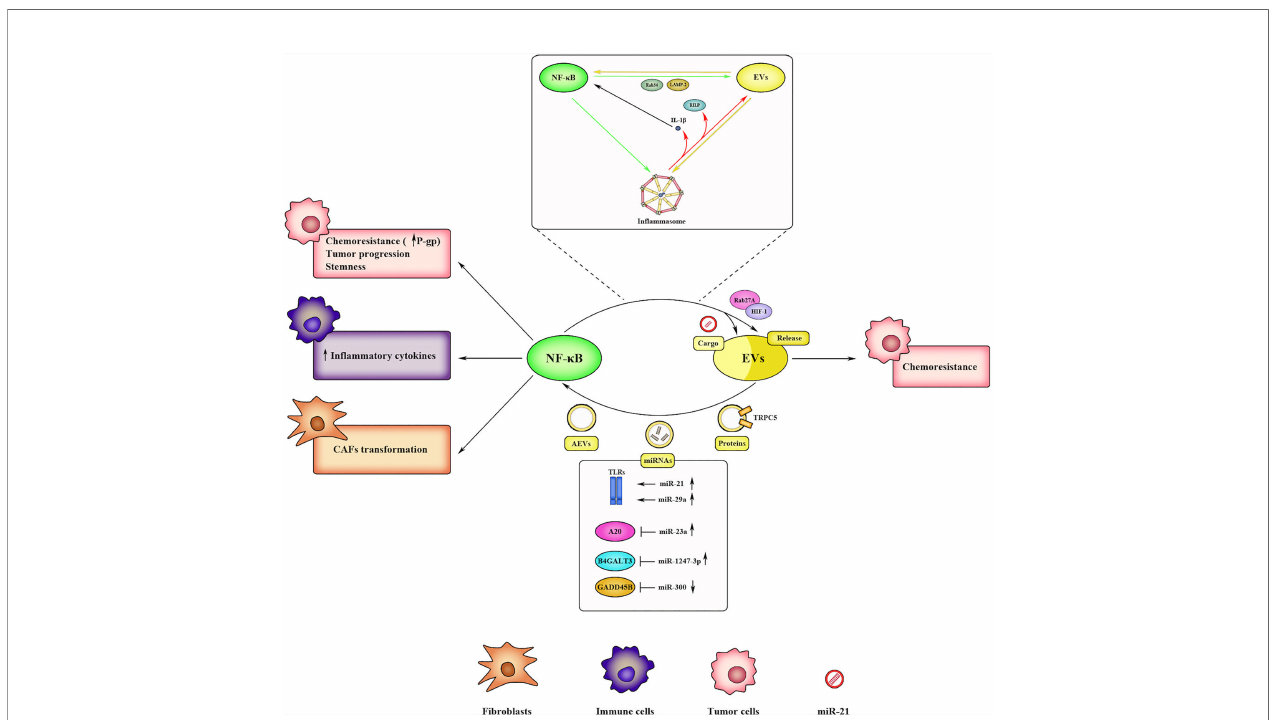
FIGURE 4 | Bidirectional communication between NF- k B and EVs within the TME. NF- k B promotes EV-mediated chemoresistance in cancer cells by regulating the expression of EV-releasing factors ( i.e. , Rab27A, Rab34, LAMP-2, HIF-1). NF- k B also affects EV cargo by inducing miRNA transcription ( i.e. , miR-21). Reciprocally, EVs activate NF- k B through several mechanisms, such as by acting as DAMPs or delivering speci fi c proteins and miRNAs. Upon activation, NF- k B induces chemoresistance, progression, and stemness in tumor cells, in fl ammatory cytokines release in immune cells, and CAFs transformation in fi broblasts. In fl ammasome often mediates the crosstalk between NF- k B and EVs. Activated in fl ammasome promotes EV release through speci fi c factors ( i.e. , RILP) and sustains NF- k B signaling through IL-1 b production. In turn, NF- k B regulates in fl ammasome activation by promoting priming step, and reciprocally, EVs induce in fl ammasome signaling, thus generating a positive feedback